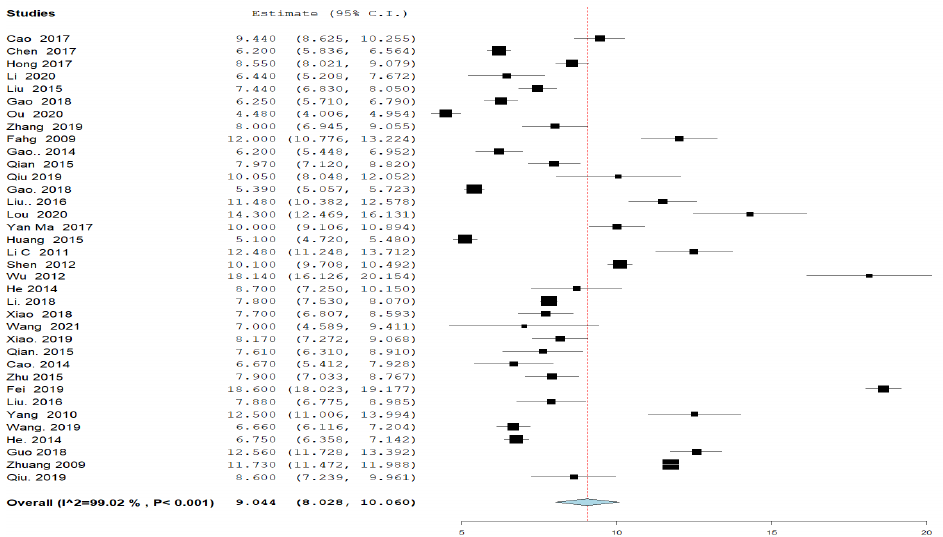
Figure 2. A forest plot of the duration of postprocedural hospital stay in days.